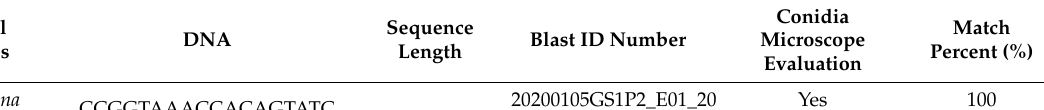
Table 1. Molecular and Microscopic Identification from plant samples and T. confusum dead cadavers Blast ID Number, DNA, Sequence length, Conidia microscope evaluation, and Match